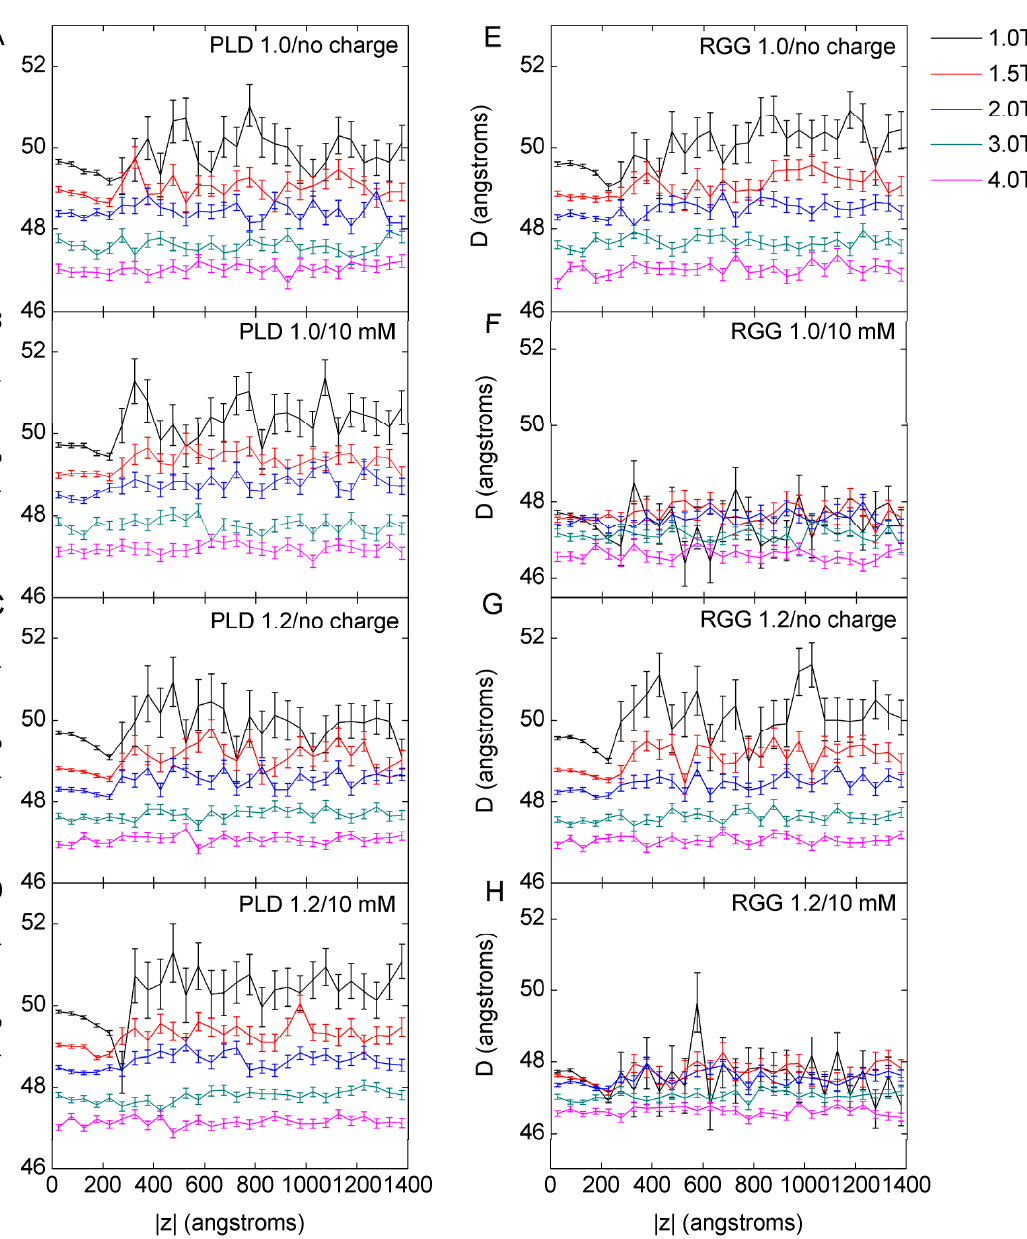
Figure 9. Head-to-tail distance (D) of PLD and RGG as a function of displacement |z|. ( A ) The head-to-tail distance of PLD 1.0 with no charge interaction. ( B ) The head-to-tail distance of PLD 1.0 with 10 mM salt solvent. ( C ) The head-to-tail distance of PLD 1.2 with no charge interaction. ( D ) The head-to-tail distance of PLD 1.2 with 10 mM salt solvent. ( E ) The head-to-tail distance of RGG 1.0 with no charge interaction. ( F ) The head-to-tail distance of RGG 1.0 with 10 mM salt solvent. ( G ) The head-to-tail distance of RGG 1.2 with no charge interaction. ( H ) The head-to-tail distance of RGG 1.2 with 10 mM salt solvent. Mean D of the chains in each window along |z| and standard error ( σ ) values during the last 1000 τ simulation data are illustrated in this figure. Considering the effect of boundary, the data with displacement z higher than 1400 are not calculated.